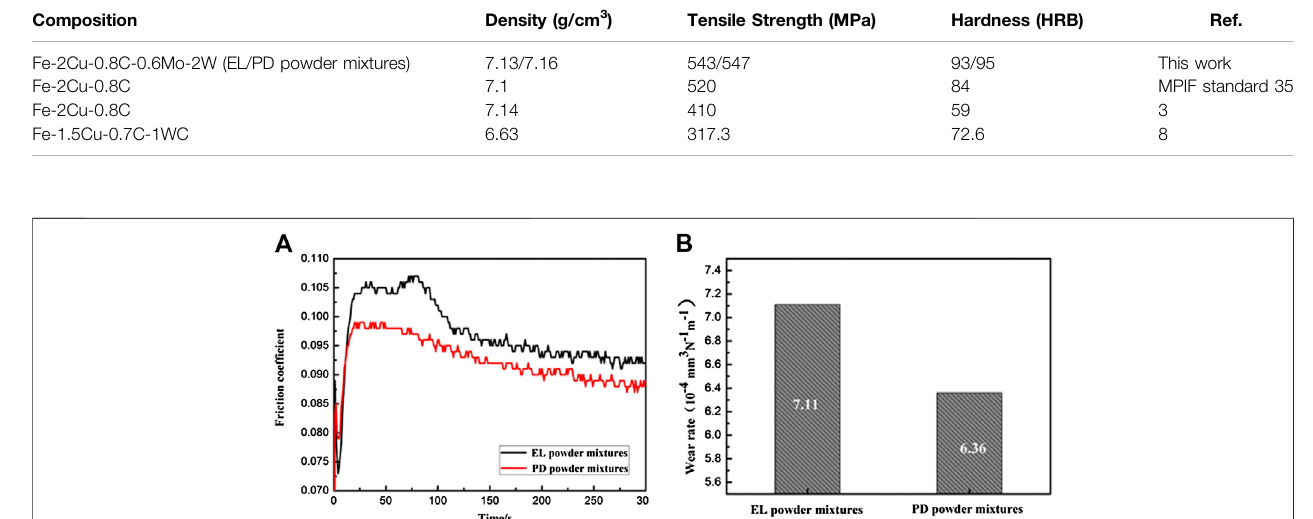
FIGURE 9 | Friction coef fi cient and wear rate of the sintered samples from different powder mixtures. (A) EL powder mixtures; (B) PD powder mixtures.